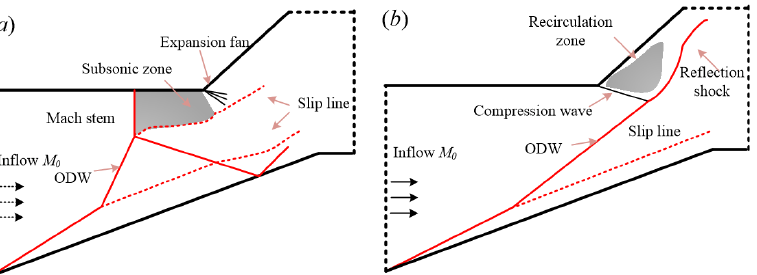
Figure 3. Two typical wave structures: ( a ) with a Mach stem of detonation, ( b ) with a postcorner recirculation zone.